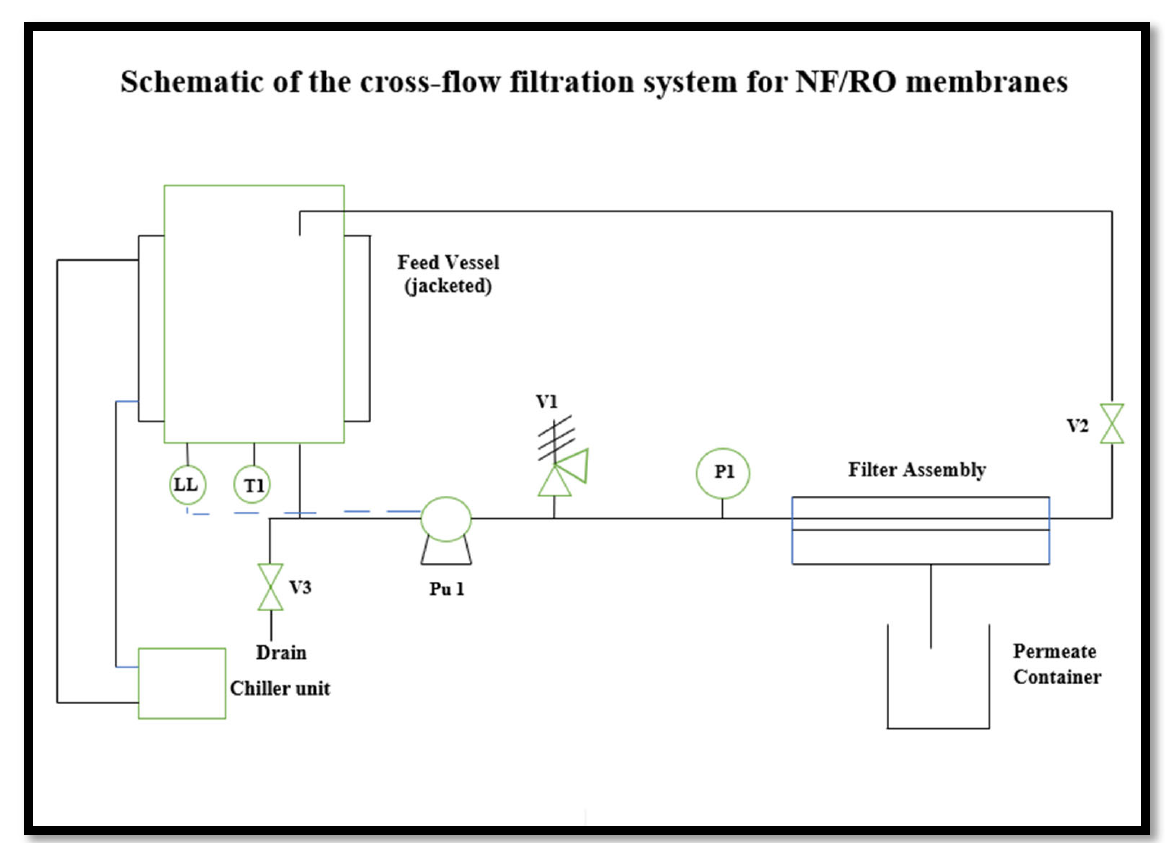
Figure 2. Legend: PI: pressure indicator (left); LL: low-level sensor (pump protection); LH: high level (vessel overfilling protection); P1: pressure sensor; T1: temperature sensor; V3, V2, V1: valves.